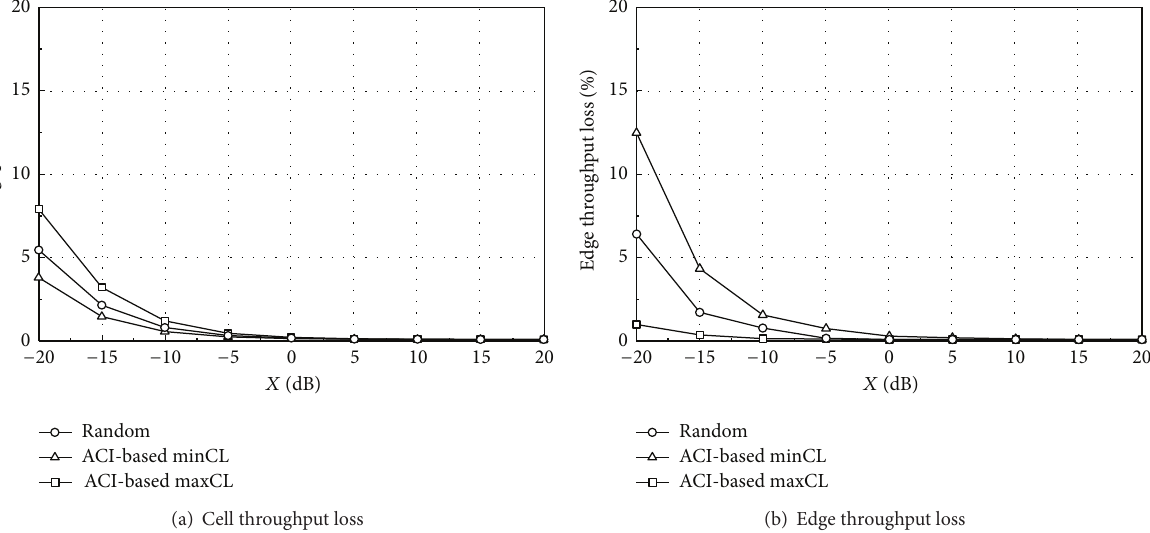
Figure 9: Throughput loss (TPC set 2, coordinated).